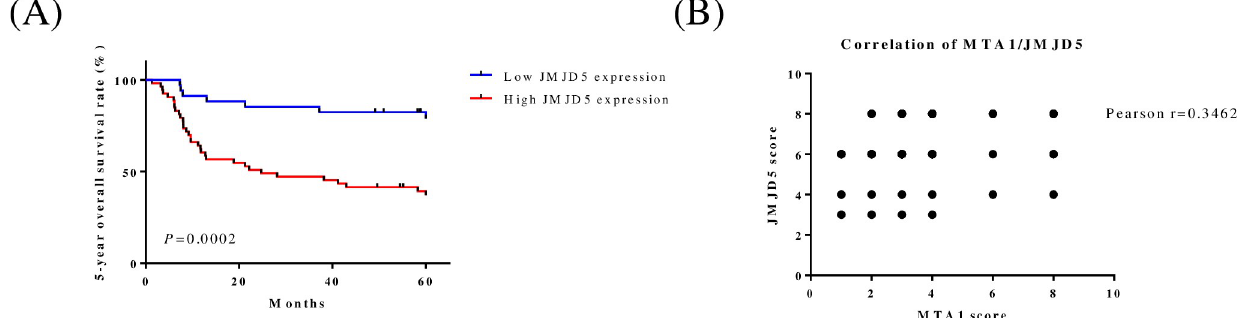
Fig 2. High JMJD5 expression was associated with poor prognosis for oral cancer patients. (A) The Kaplan–Meier curve compares the 5-year overall survival of oral cancer patients with high- or low-level JMJD5 protein products. Samples that have IHC scores > 4 are defined as having high JMJD5 expression. (B) Correlation analysis of JMJD5 and MTA1 expression in OSCC tissue microarray.